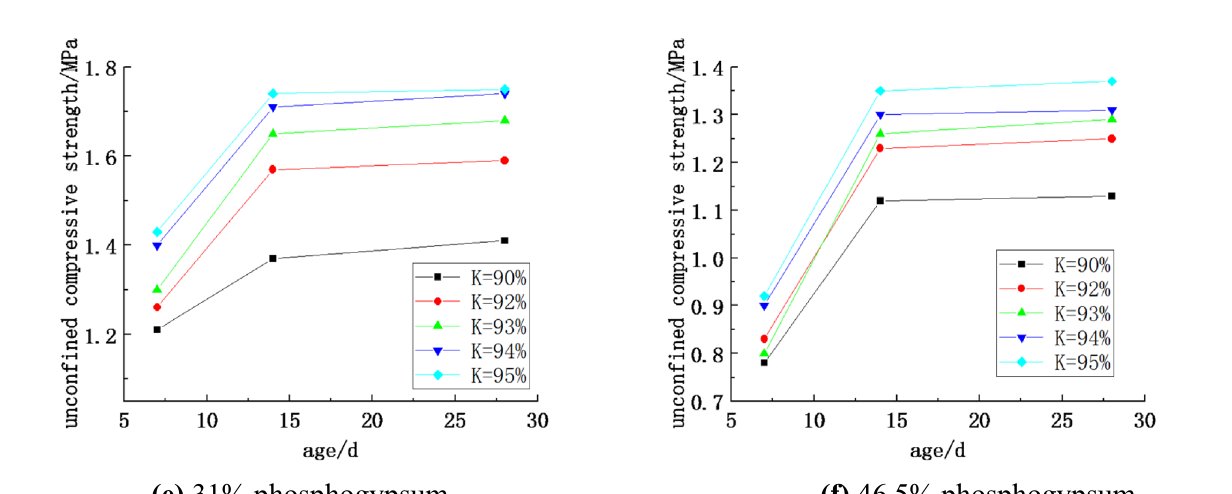
Fig. 4 Relationship curve between unconfined compressive strength and age of mixture (7%